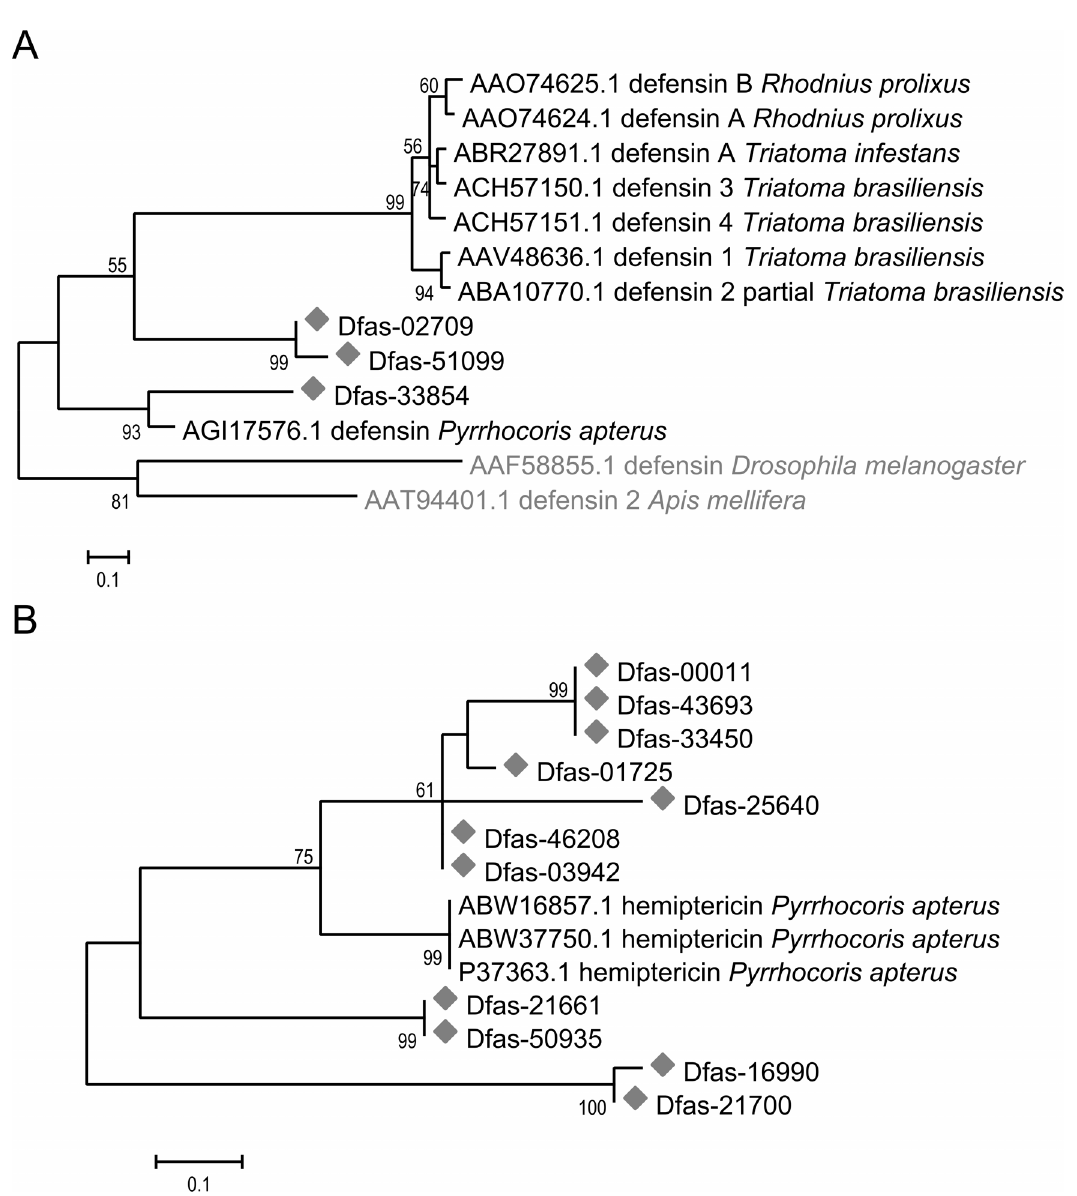
Fig. 4. Maximum likelihood phylogenetic trees of defensin (A) and hemiptericin (B) transcripts. Sequences recovered in this study are marked with a grey diamond, sequences used as an outgroup are marked in grey font. Bootstrap values above 50% are given at the nodes (based on 500